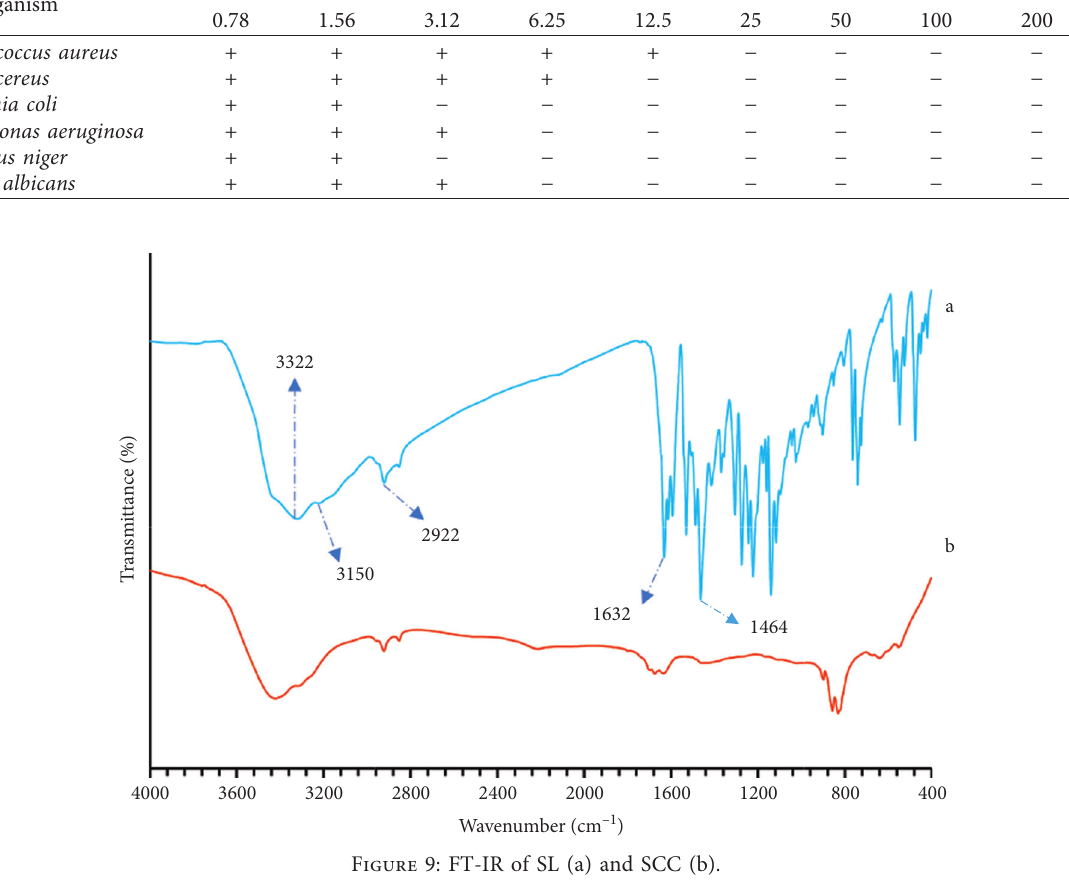
Table 2: The minimum inhibitory concentration (MIC) of microbe’s CuNPs in different concentrations (measured in µ g.ml − 1 ).